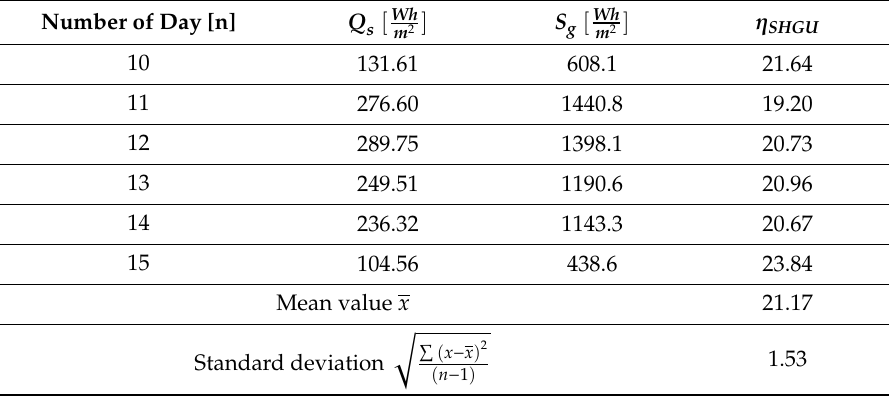
Table 4. Daily sums of solar gains Qs , solar irradiance measured behind the outer glazing of IGW and calculated efficiency η SHGU .